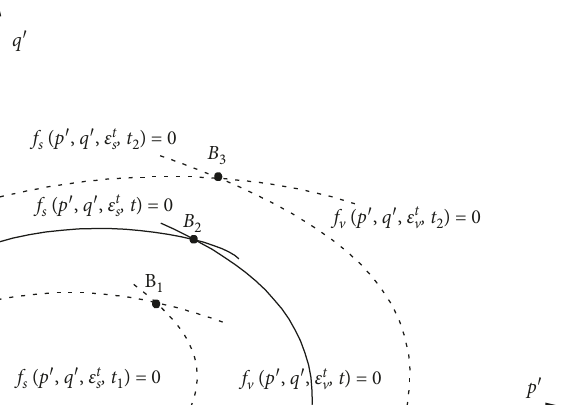
Figure 14: The schematic diagram of both nonstationary compression and shear surfaces. For a given viscoplastic strain, the stress point which lies in a flow surface will be reached at different points B1, B2, or B3 over time ( t ). When soil is seen as an elastoplastic material and viscoplastic strains remain constant, the stress point will be reached at the same point (such as B1) along a given load path, which is independent of